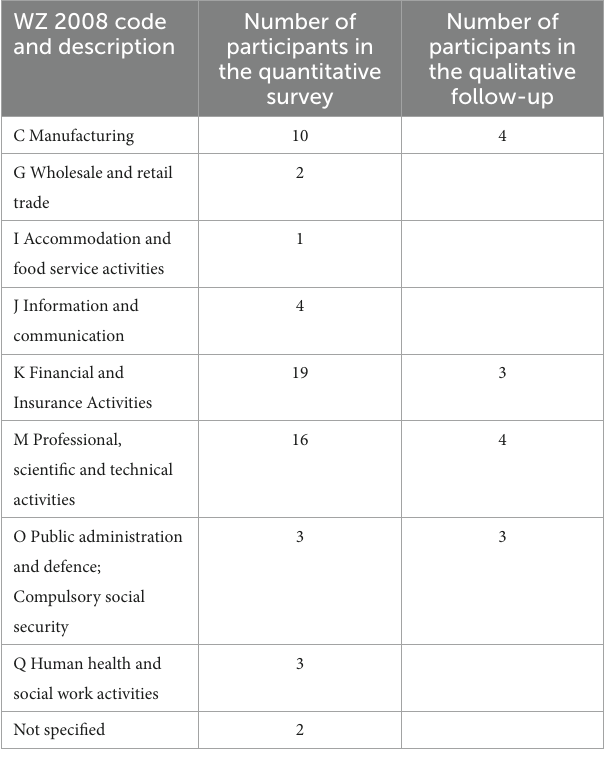
TABLE 1 Overview of the economic activities of the participants’ organizations – Classification of Economic Activities, Edition 2008 (WZ 2008) (Federal Statistical Office Germany,